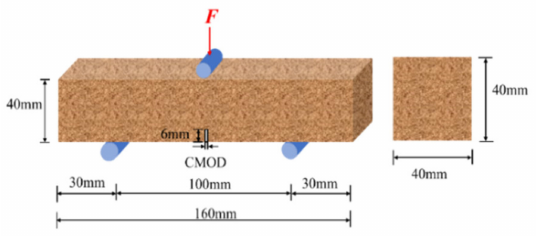
Figure 1. Schematic diagram of size of three-point bending specimen.